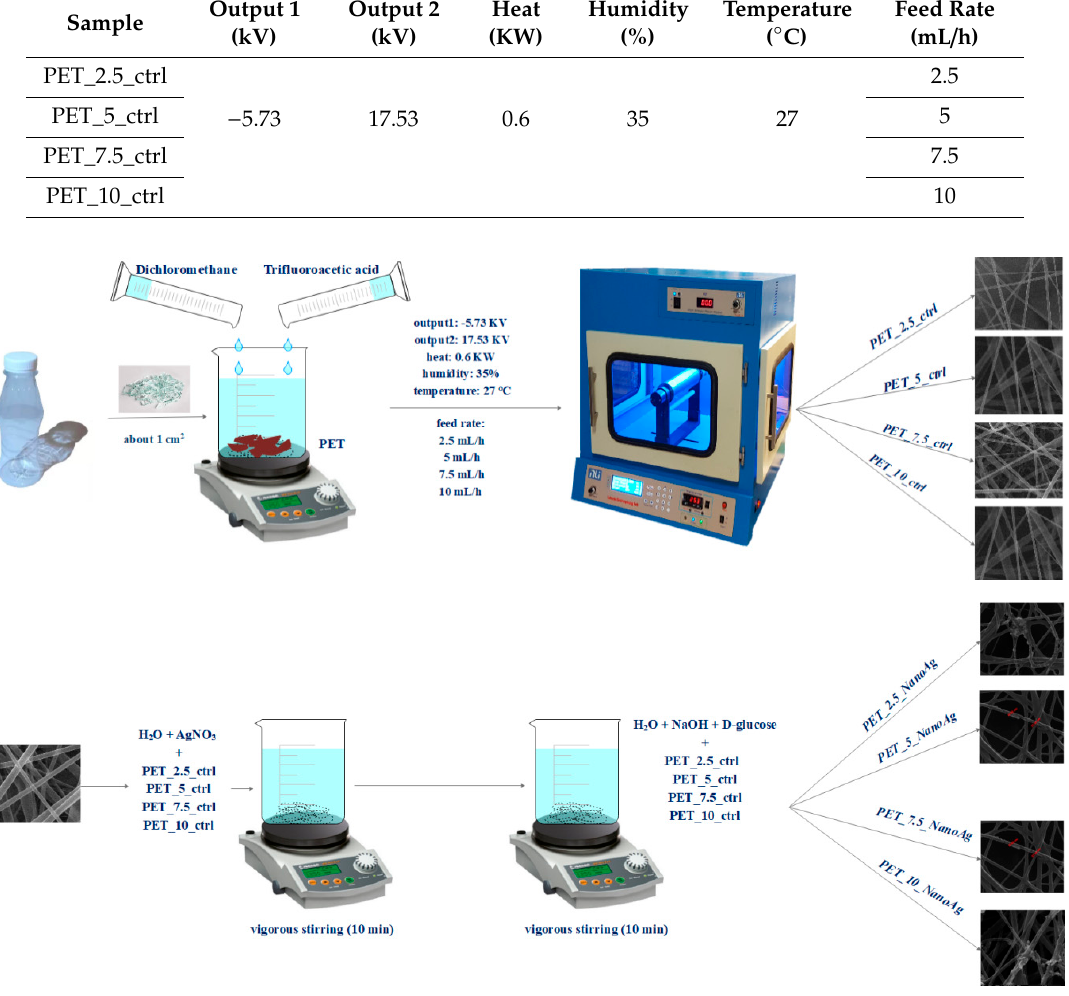
Table 1. The parameters utilized for electrospinning. PET—polyethylene terephthalate.